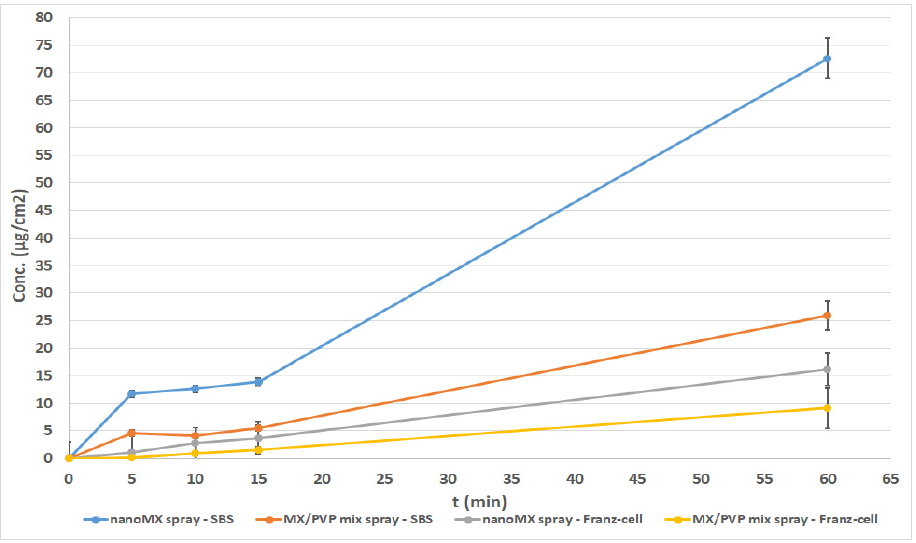
Figure 4. In vitro permeability of intranasal sprays on Franz and Side-Bi-Side diffusion